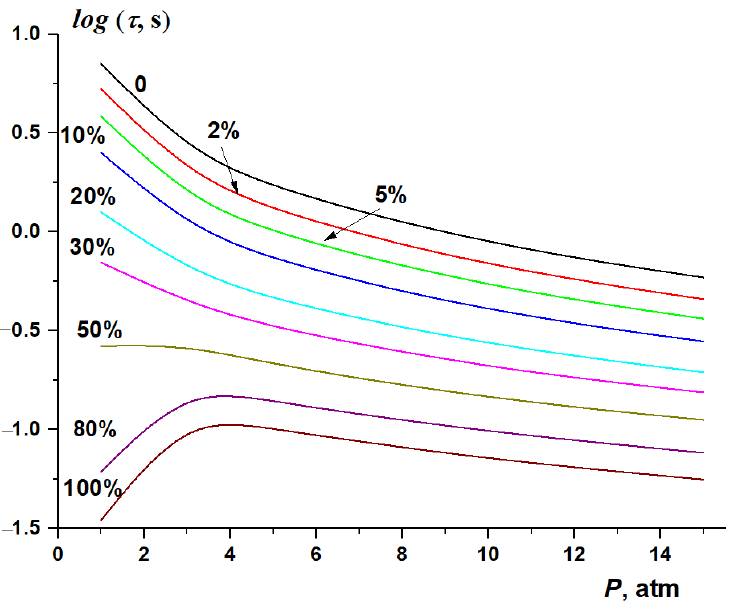
Figure 12. Dependence of the autoignition delay time of stoichiometric of CH 4 – H 2 – air mixtures on the initial pressure at T 0 = 900 K and various hydrogen concentrations.